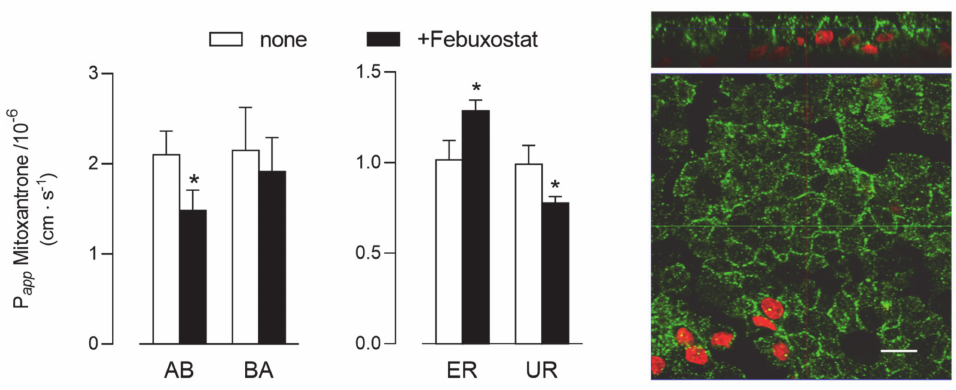
Figure 7. BCRP activity and expression in EpiArway ™ cultured under ALI conditions for 21 d. Left: the apical-to-basolateral (AB) and basolateral-to-apical (BA) fluxes of 3 H-mitoxantrone (0.1 µ M, 1 µ Ci / mL) were monitored both in the absence (none) and in the presence of 10 µ M Febuxostat, as indicated. Data obtained were employed to calculate the e ffl ux (ER) and uptake (UR) ratio, as defined in Methods. Bars represent the mean ± SEM of three independent experiments. * p < 0.05 vs. none. Right: the expression of the transporter was evaluated by means of confocal laser scanning microscopy. Green signal: BCRP immunolabeling; red signal: nuclear staining with propidium iodide. A single XY scan is shown, along with the XZ section of the plane (top). Scale bar = 10 µ